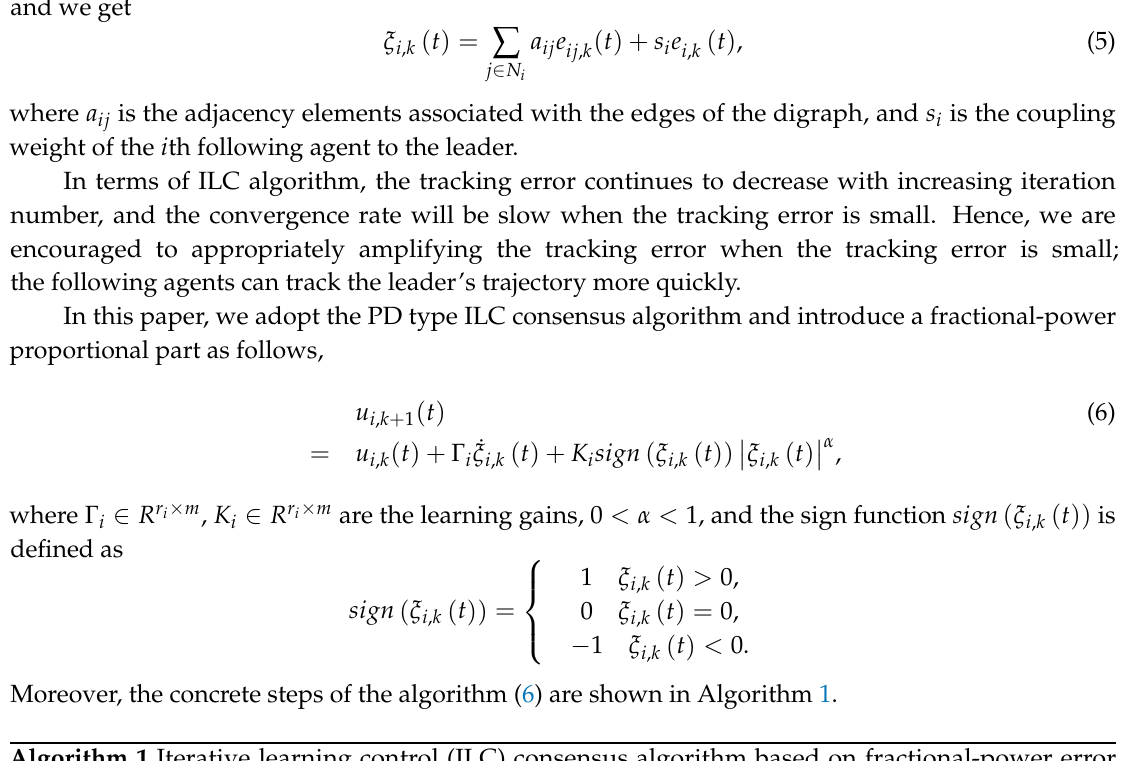
Algorithm 1 Iterative learning control (ILC) consensus algorithm based on fractional-power error